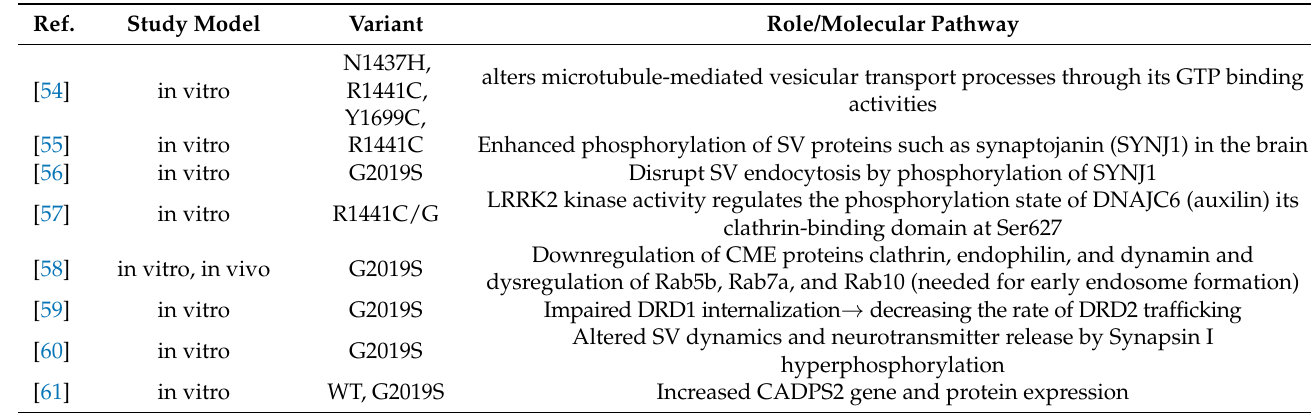
Table 6. Impact of LRRK2 on vesicle trafficking